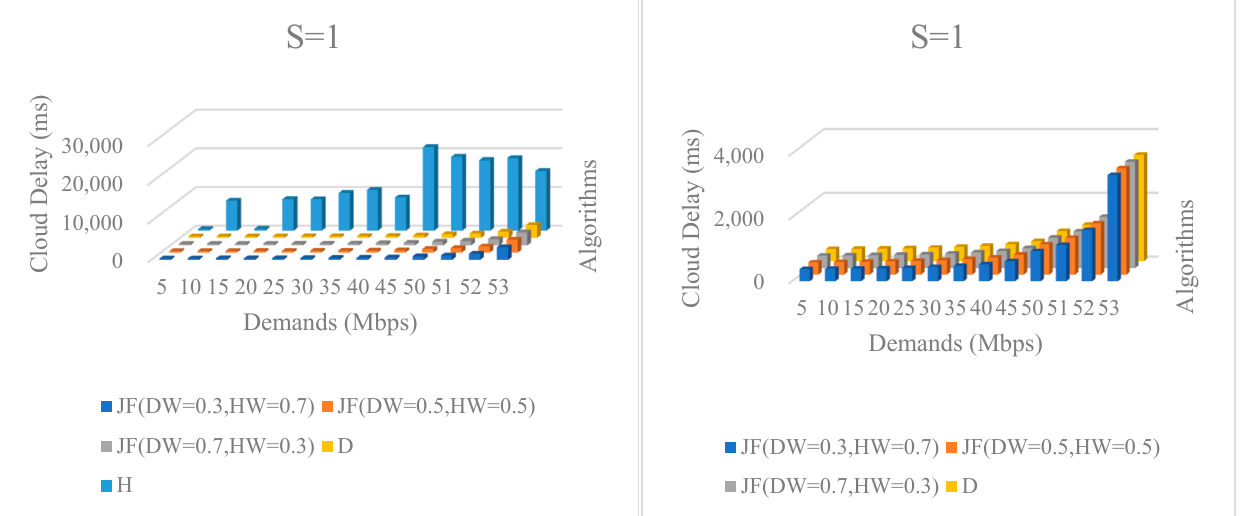
Figure 5. Cloud delay under various communication demands. The left part contains all three algorithms (JF with three different hyperparameters, D and H). The right removes the consequences of H algorithm for the convenience of comparison.